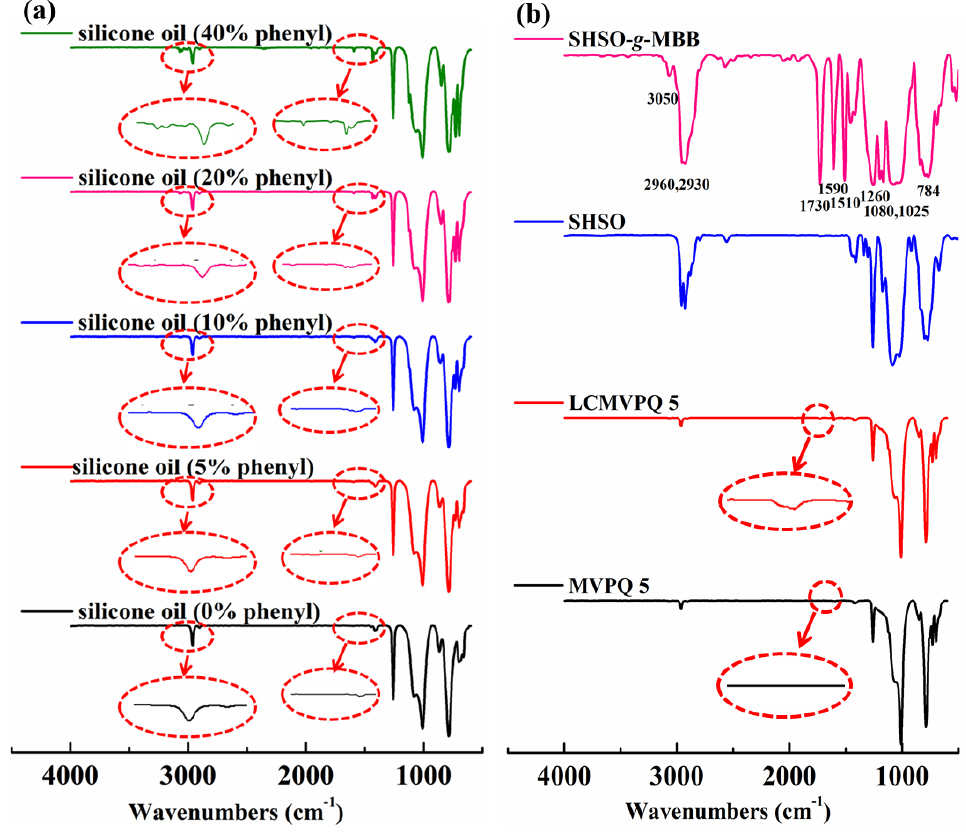
Figure 2. FT-IR spectra of ( a ) silicone oils with different phenyl content, ( b ) SHSO- g -MBB, SHSO, LCMVPQ 5 and MVPQ 5.